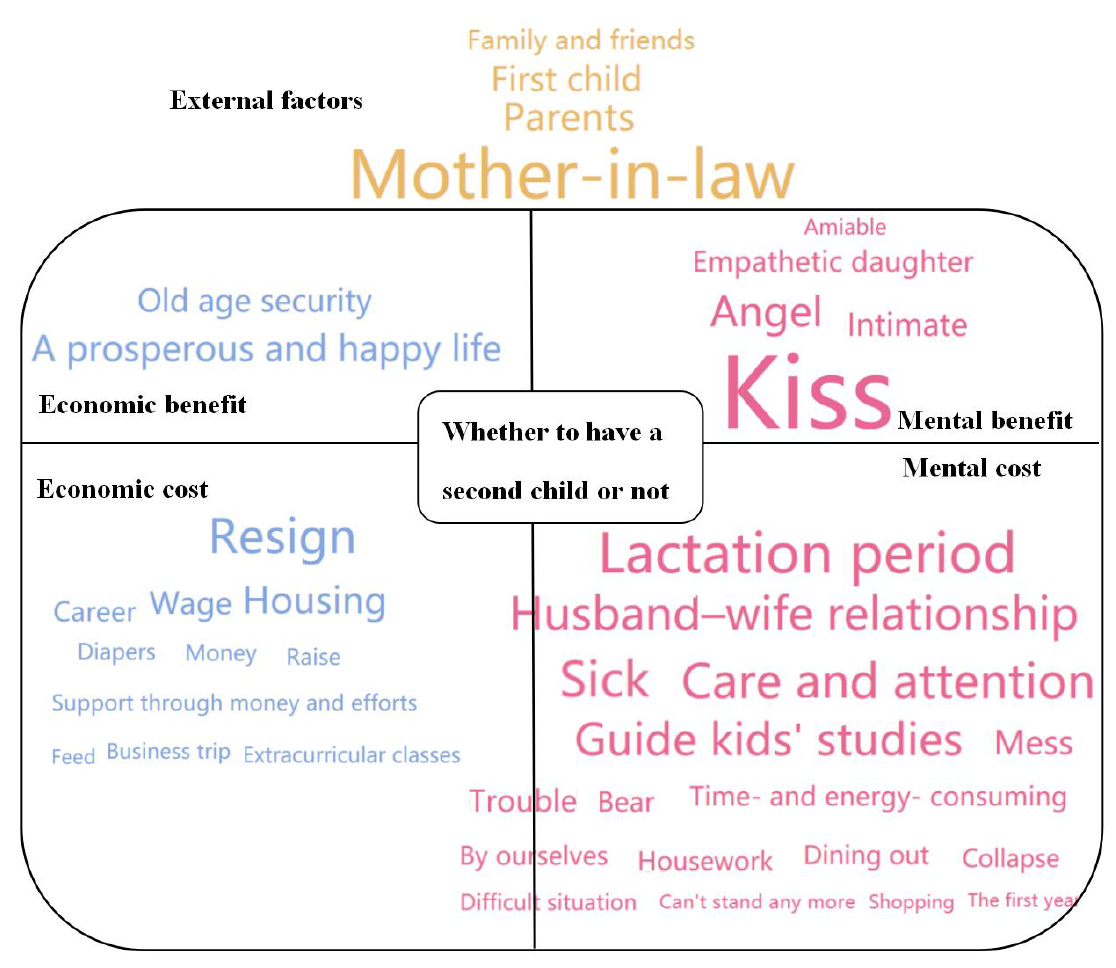
Figure 4. In-depth reasons for deciding whether or not to have a second child.